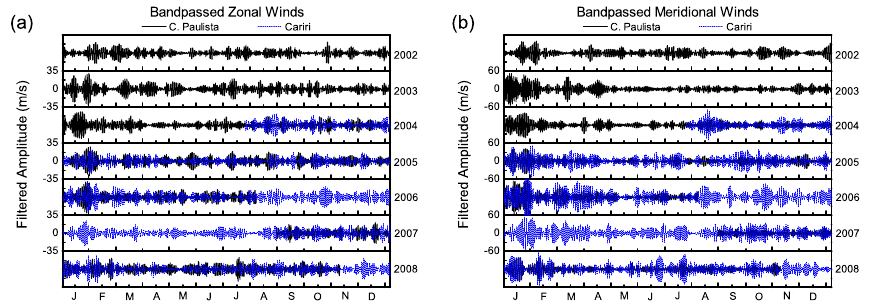
Figure 2. Band-passed hourly (a) zonal and (b) meridional winds over Cariri (blue doted line), for the years 2004 to 2008, and over C. Paulista (solid black line), for the years 2002 to 2008, at 90km. The passband limit was 1.5 to 2.5 days, centered on 2 days. Fig. 2. Bandpassed hourly (a) zonal and (b) meridional winds over Cariri (blue dot), for the years 2004 to 2008, and over C. Paulista (black line), for the years 2002 to 2008, at 90 km. The pass-band limits used was 1.5 to 2.5 days, centered on 2 days.